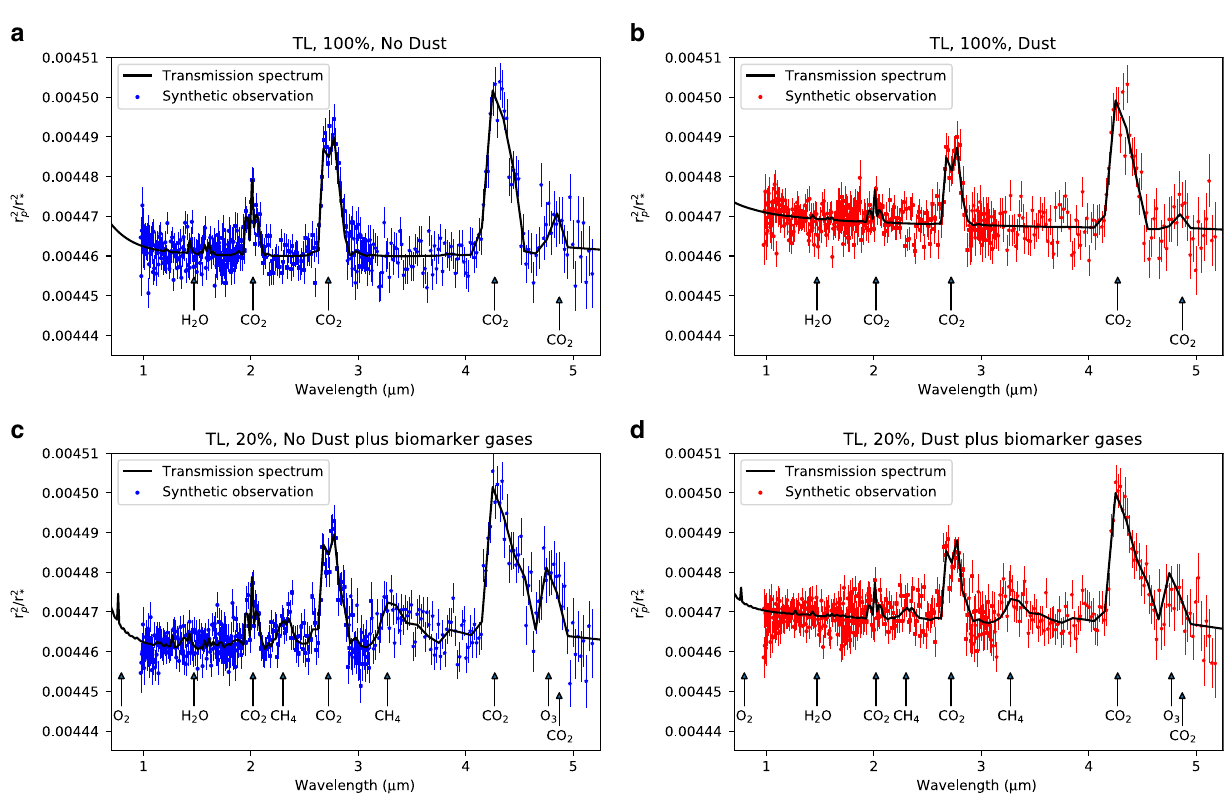
Fig. 4 Effect of dust on planetary observations. Simulated transmission spectra (black) and synthetic JWST observations (blue/red), from 15 transits for a dusty ( b , d ) and non-dusty ( a , c ) tidally locked planet, orbiting an M dwarf of apparent magnitude similar to Proxima Centauri, with 100% land coverage and no potential biomarker gases ( a , b ), and 20% landcover and biomarker gases ( c , d ). A one-standard deviation error on the synthetic observation is